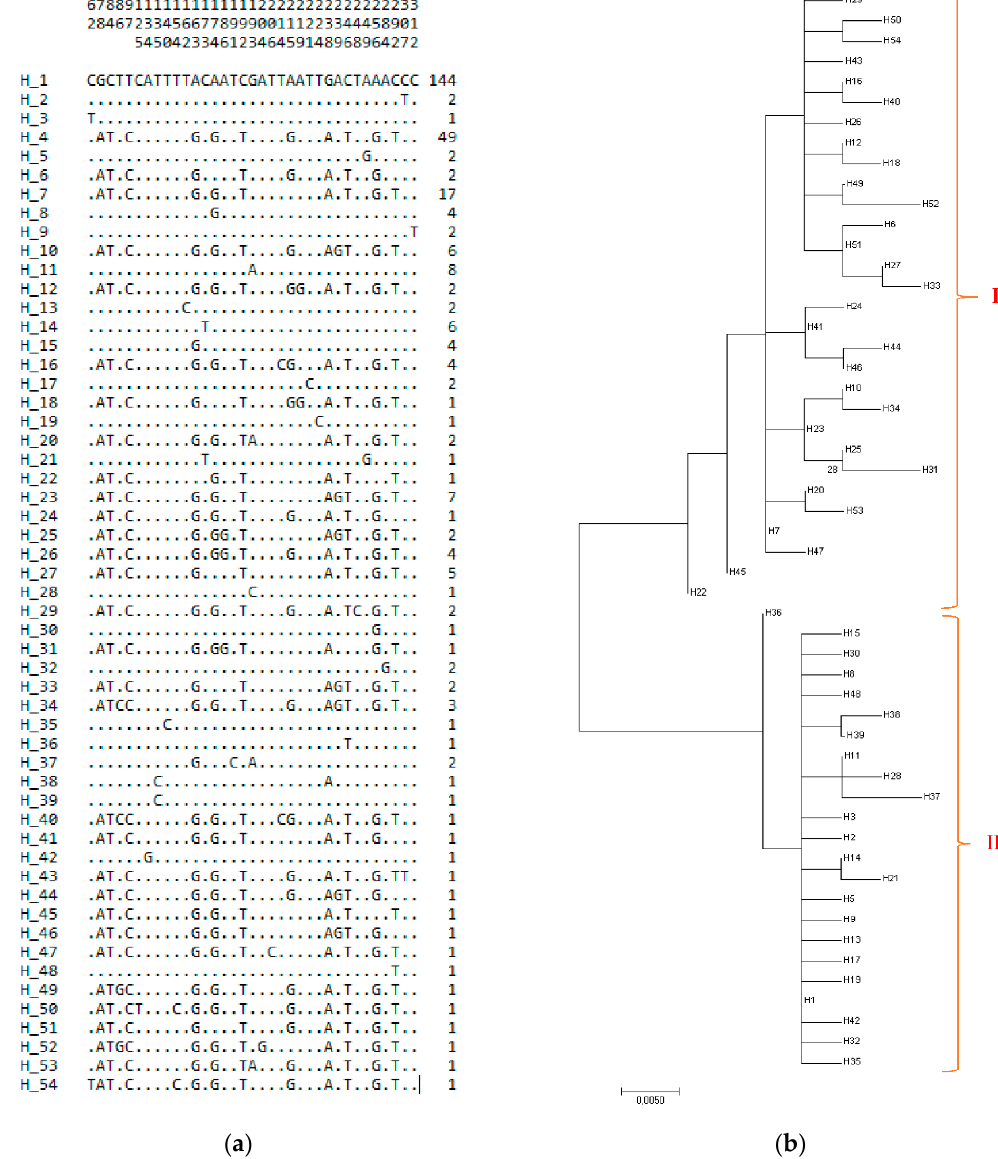
Figure 2. ( a ) Polymorphic sites and haplotypes, ( b ) neighbor joining tree by maximum likelihood method distribution of haplotypes in Turkish indigenous donkeys. Table 2. Genetic characterization of the 16 Turkish donkey populations.